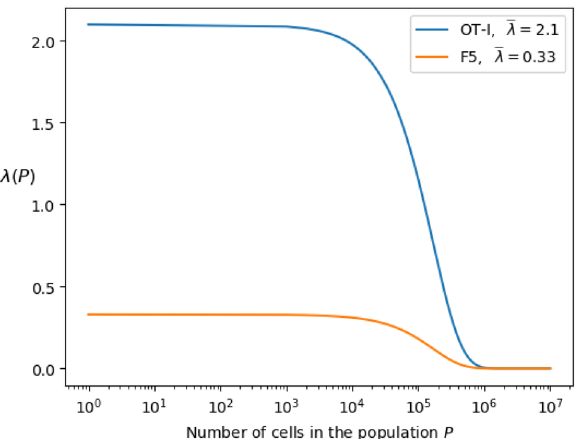
Figure 6. Density-dependent birth rate, (cid:31) ( P ) , as a function of the population size, P . The parameter ¯ (cid:31) , with day − 1 , represents the rate of growth under no competition and δ quantifies the level of reduction units of cell · caused by the expansion of competing cells. Values for ¯ (cid:31) (shown in the inset) and δ from 20 , Table 1].